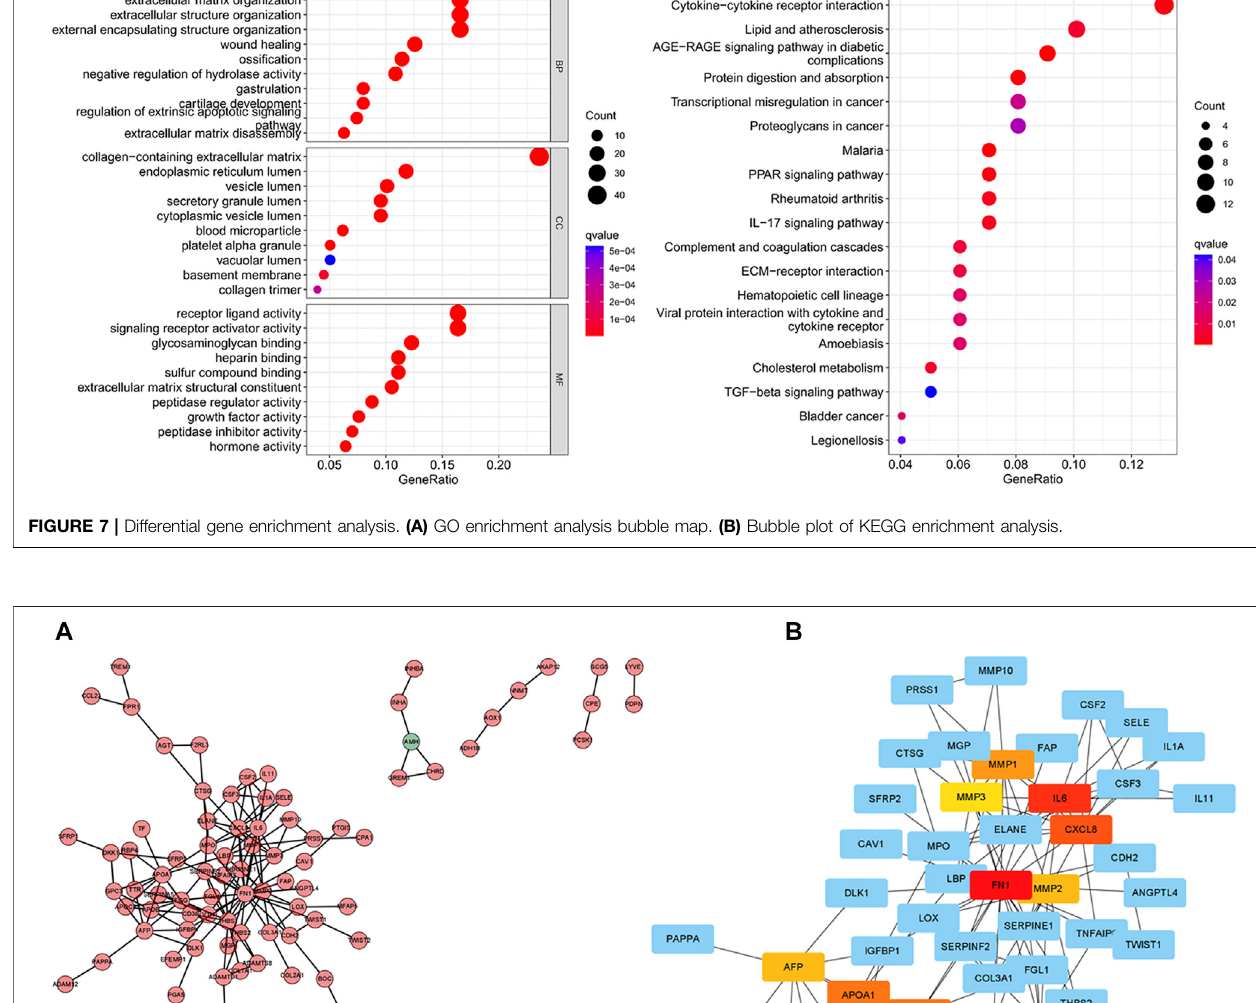
misregulation in cancer, and proteoglycans in cancer were signi fi cantly enriched in the KEGG bubble plots ( Figure 7B ).